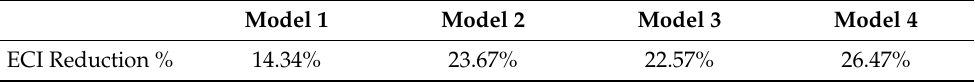
Table 9. Average ECI reduction of Models 1, 2, 3, and 4 compared to the control model.